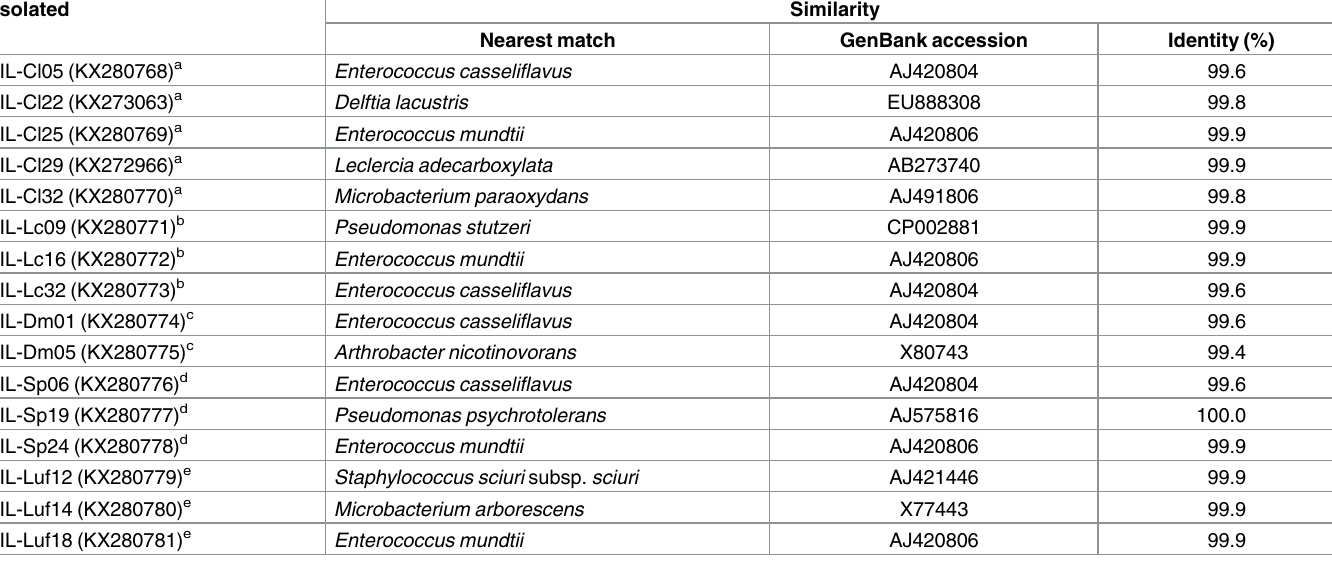
Table 2. Putative identification of bacterial isolates obtained from the larval gut of strains of Spodoptera frugiperda resistant to different insecticides.